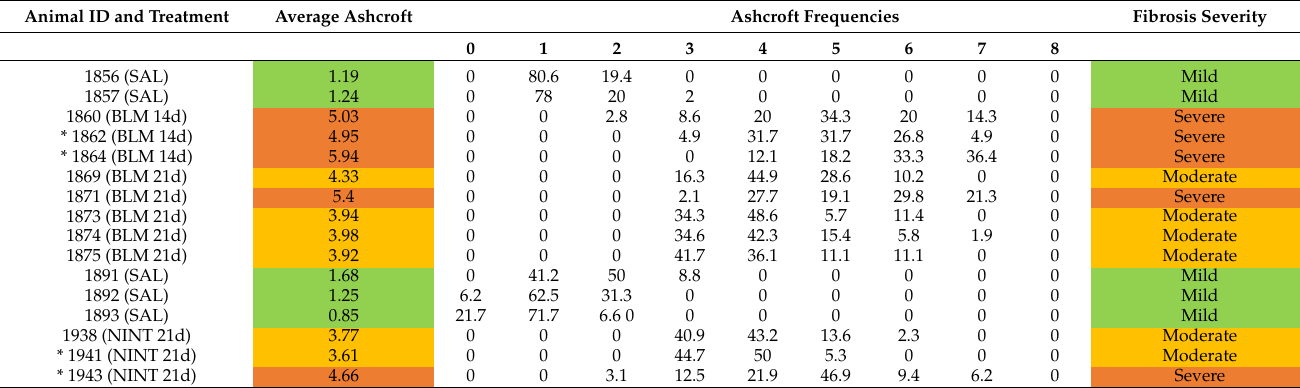
Table 1. List of analyzed mice with their ID and treatment, average Ashcroft, Ashcroft frequencies, and fibrosis severity. Fibrosis severity was evaluated based on the average Ashcroft score: mild ( x ≤ 3.5), moderate ( x > 3.5 or ≤ 4.5), severe ( x > 4.5). * FFPE lung tissue blocks of these samples were prepared from both left and right lungs. SAL—saline; NINT—nintedanib; and